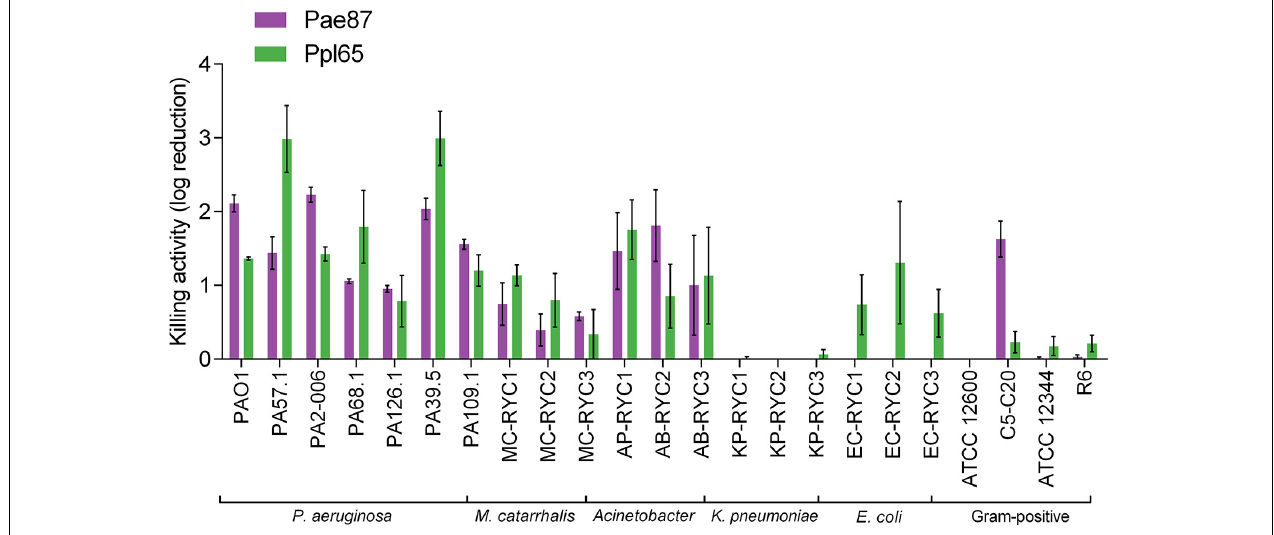
FIGURE 7 | Bactericidal activity range of Pae87 and Ppl65. Decrease in the viable cell counts of bacterial suspensions treated with 10 µ M enzyme (2 h, 37 ◦ C) with respect to an untreated control is